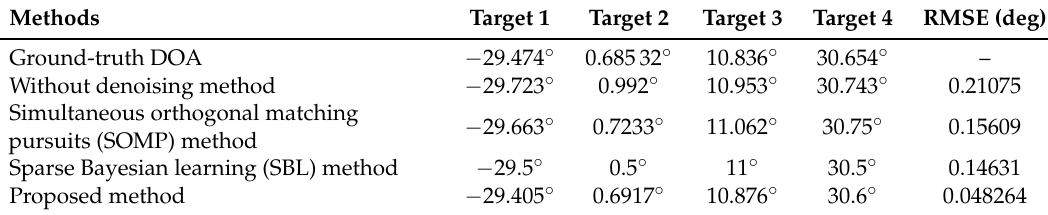
Figure 2. The spatial spectrum for direction of arrival (DOA) estimation. Table 2. DOA Estimation